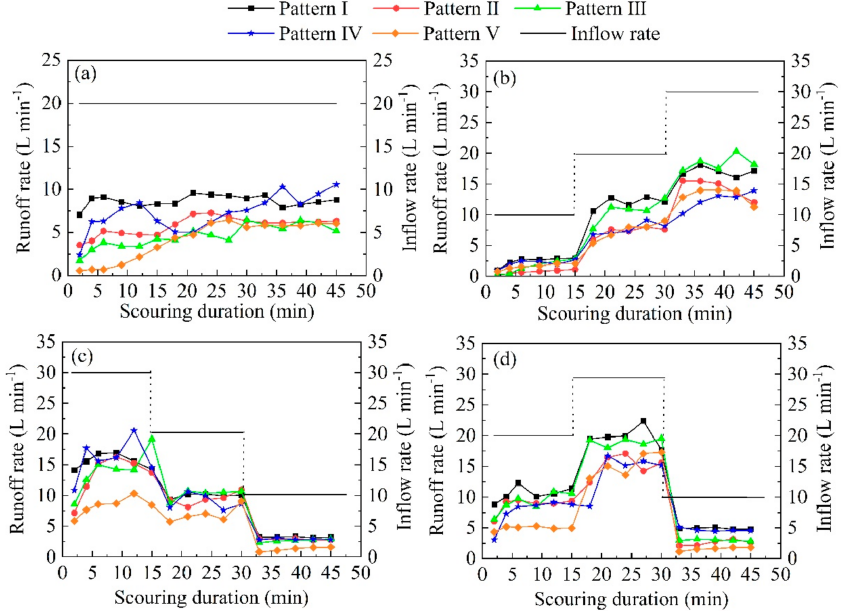
Figure 6. Changes in runoff rate under different inflow rates for different grass strip patterns: ( a ) even, ( b ) rising, ( c ) falling, and ( d )